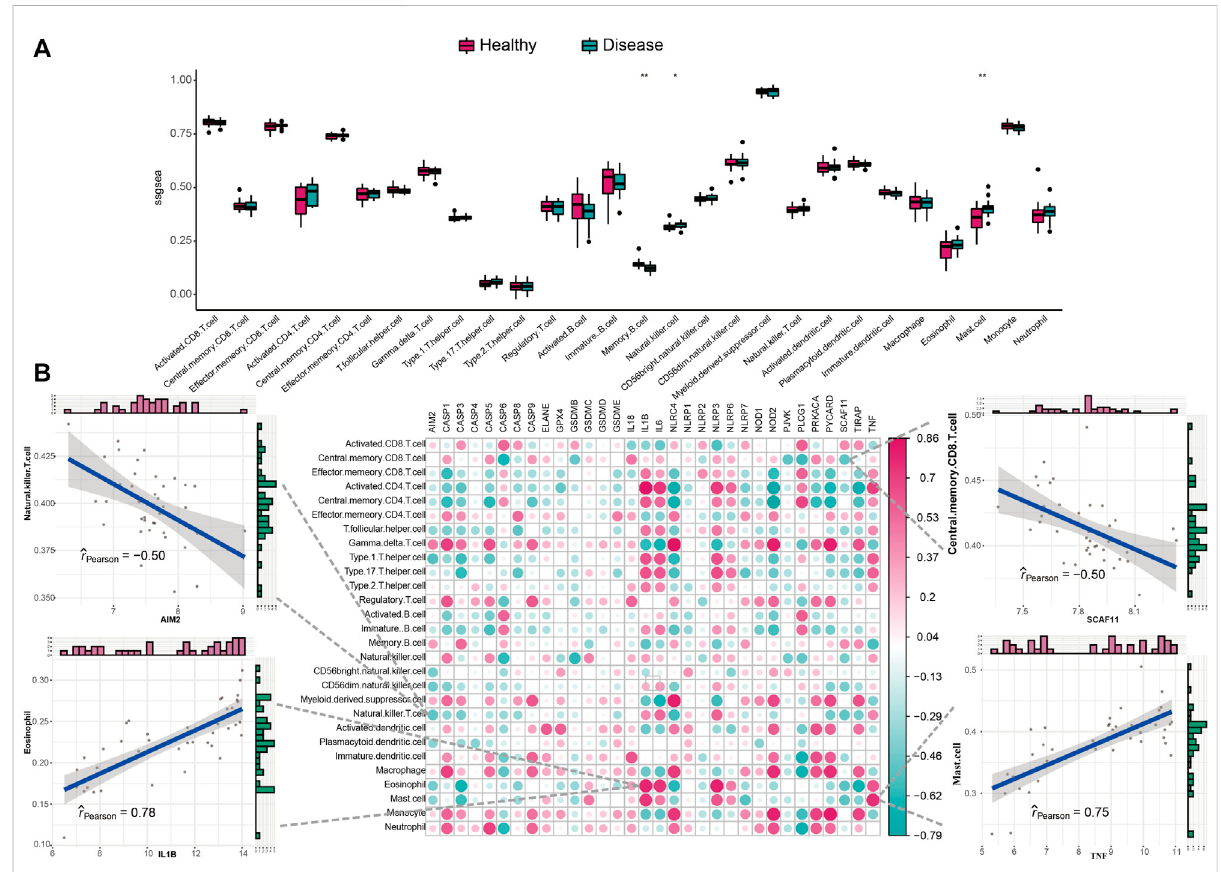
FIGURE 3 Correlation between in fi ltrating immunocytes and pyroptosis genes. (A) Difference in the abundance of each in fi ltrating immunocyte between healthy and IS samples. (B) Dot-plot demonstrated the correlations between each in fi ltrating immunocyte type and each